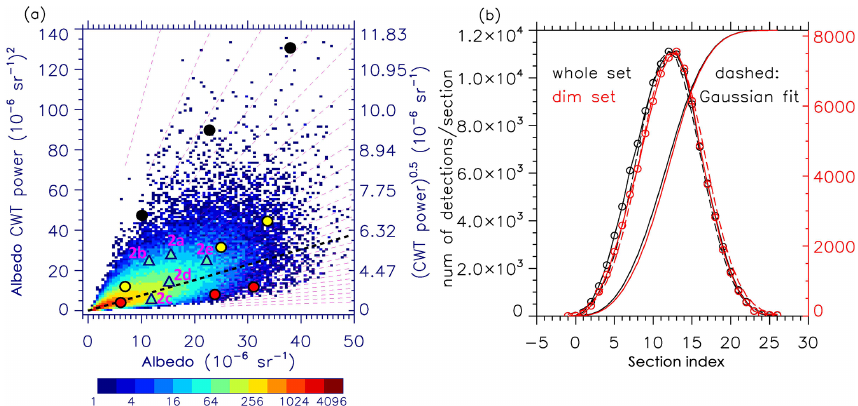
Figure 5. (a) Same as Fig. 4 except for using both dimmer and brighter sets of detections and use the mean albedo within the elliptical region as the horizontal axis. The bin of albedo is 0 . 5 × 10 − 6 sr − 1 . The turquoise triangles and colored dots are the same as in Fig. 4. (b) The normal distributions for both the dimmer subset and the full set of wave detections. The curves without symbols are accumulated fraction of detections with a vertical axial range of 0–1.0 (not shown), which is the same as in Fig.